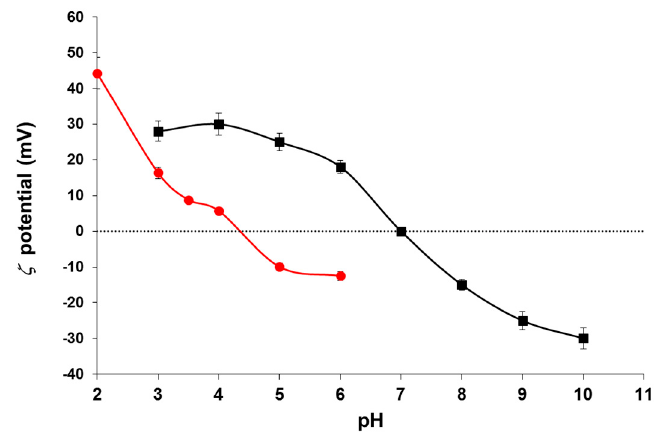
Figure 5. Zeta potential of purely inorganic MNPs ( ■ ) and biomimetic magnetic nanoparticles BMNPs ( ● ).